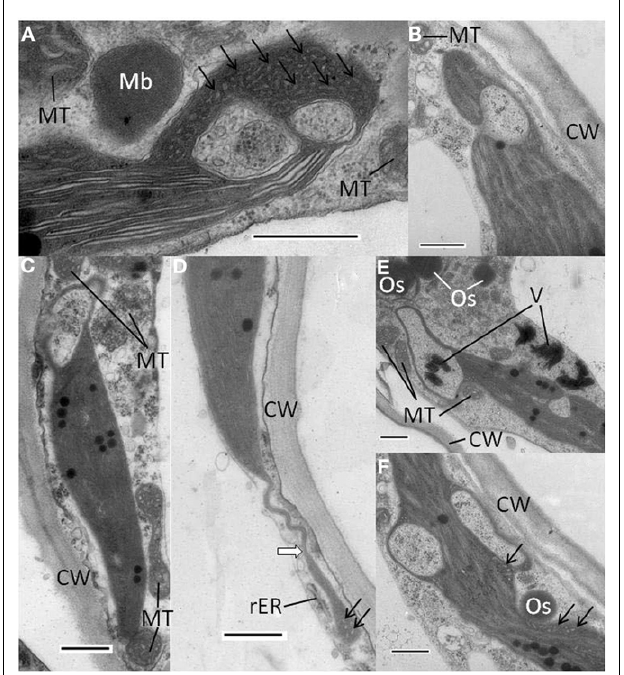
FIGURE 5 |Abnormal chloroplast morphology observed in N. benthamiana infected withAltMV over-expressingTGB3 as an